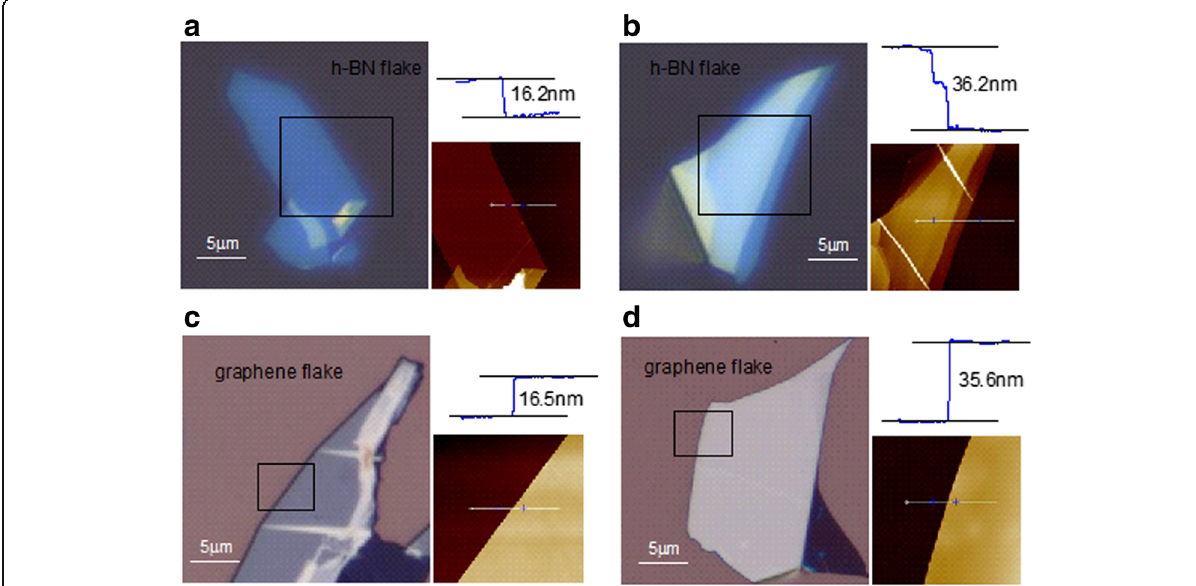
Fig. 1 a – d Optical images of the selected h-BN and graphene flakes on the SiO 2 /Si substrate. Additional insets give the respective AFM image and sample thickness of the highlighted black rectangle areas in optical